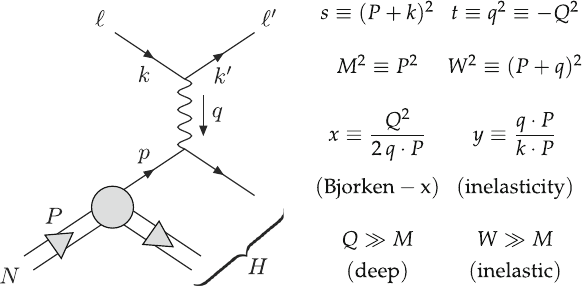
Fig. 9 The kinematics of deep inelastic scattering